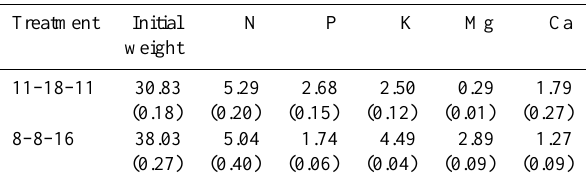
Table 2. Initial tablet weights (g) and N, P, K, Mg and Ca amounts (g) applied to each column with the treatments (average of three replicates, with standard deviation in